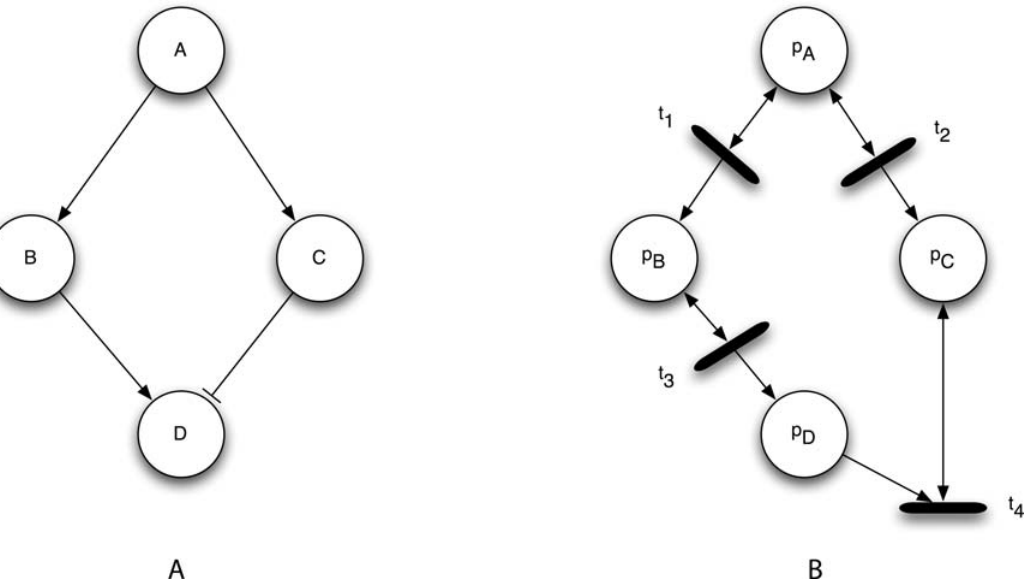
Figure 4. An Example Signaling Network and Its Corresponding Petri Net. An example signaling network (A) and its corresponding Petri net (B). Each signaling protein in the network, A, B, and C, are designated as places p A , p B , and p C . Signaling interactions become a transition node and its input and output arcs. Note that the connectivity for an activating edge differs from that of an inhibitory edge.